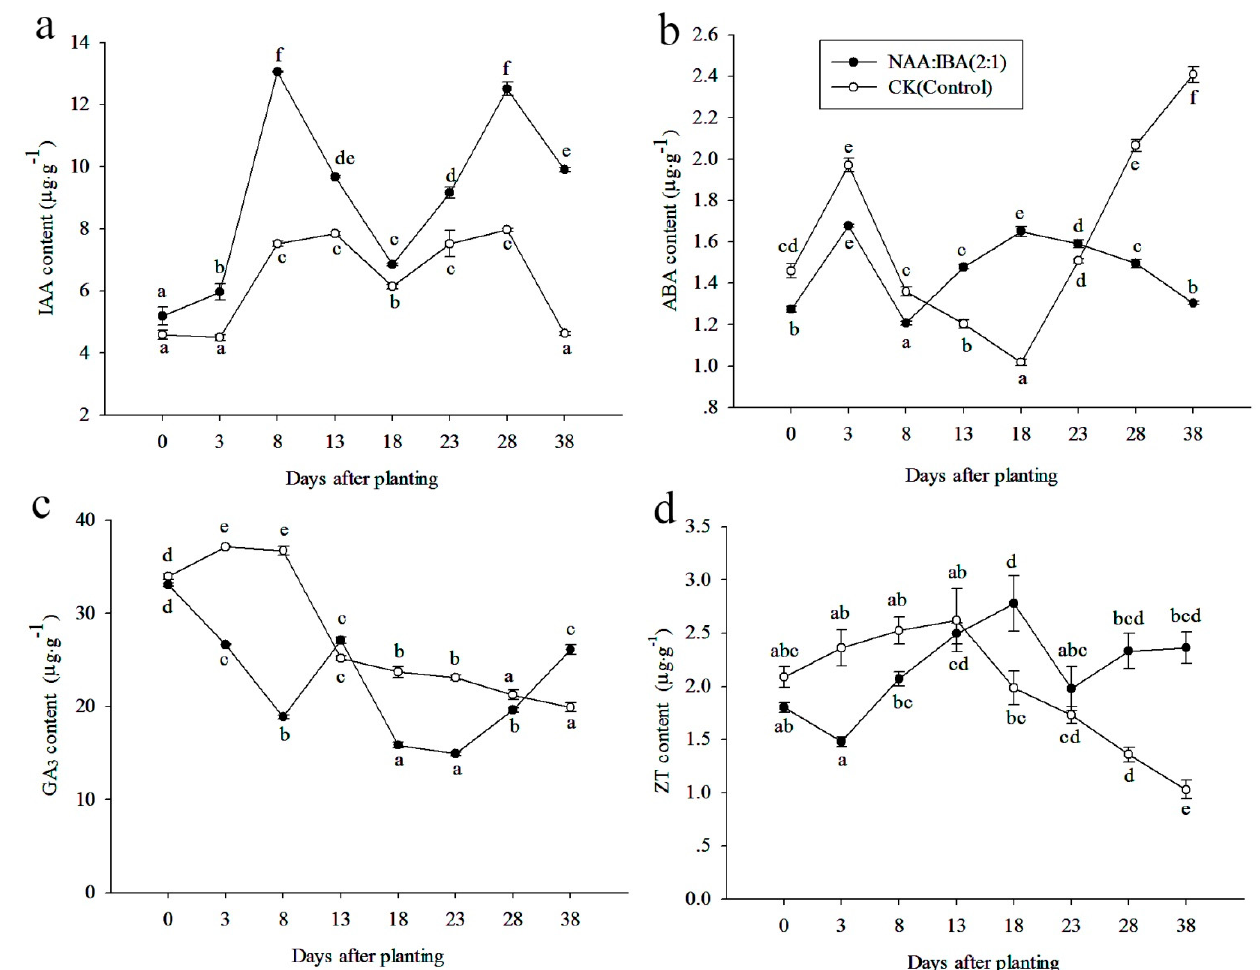
Figure 10. Changes in IAA, ABA, GA 3 , and ZT quantifications during rooting in cuttings of M. wufengensis. ( a ) IAA contents. ( b ) ABA contents. ( c ) GA 3 contents. ( d ) ZT contents. Data are the means of three replicates ± SE, for 20 cuttings per treatment. Letters on the top of each point show p < 0.05, same letters show the non-significant difference while different letters show significant difference between different days after